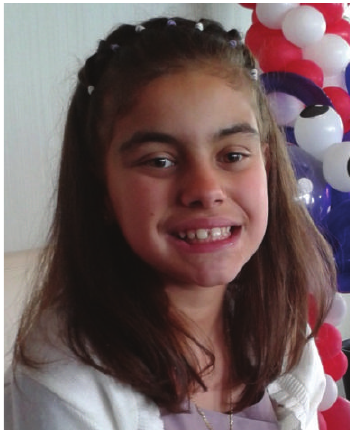
Figure 1: The facial photograph of the patient does not show any remarkable phenotypic features. Only slight facial dysmorphism could be observed: a long face with a prominent chin; broad forehead; and a broad, large mouth with widely spaced upper front teeth. Although not visible in this photograph, she has slightly protruding prominent